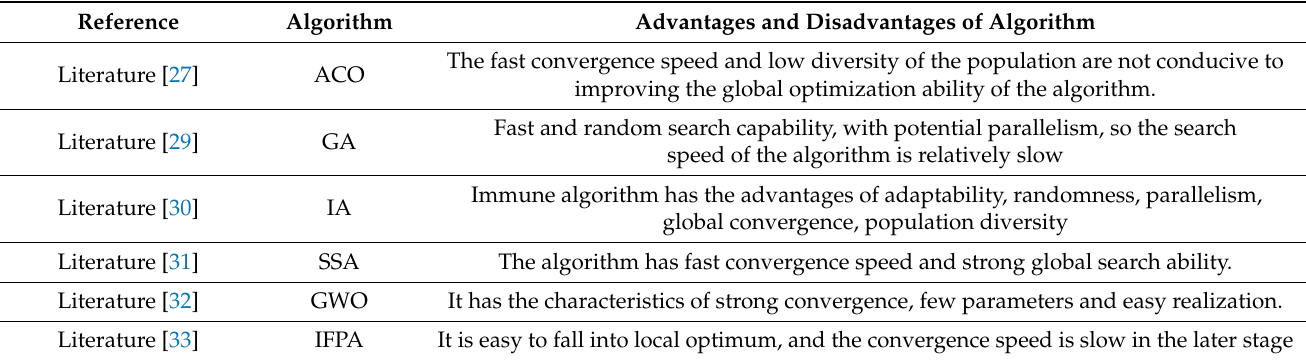
Table 1. An overview of important research in the field of optimization